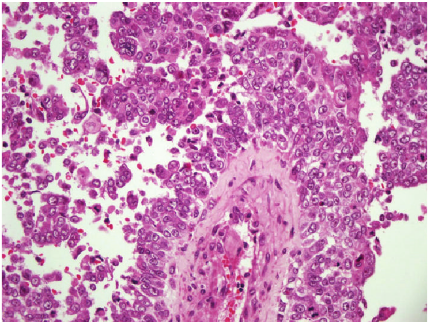
Figure 2: The sarcomatous component of the tumor [HE × 400].